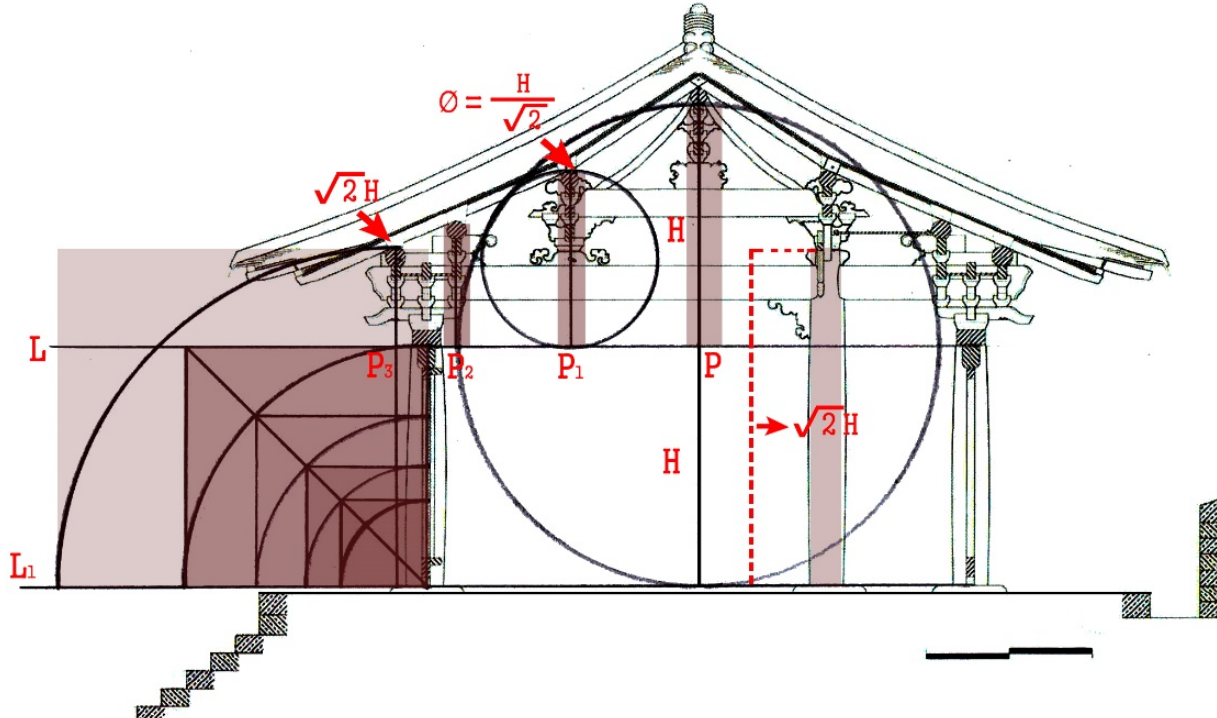
Figure 12. Daeungjeon Hall of Sudeoksa Monastery. Proportional analysis of the sectional elevation (H = eave column height, Ø = circle diameter), Adapted from CHA (2005a, p. 78).